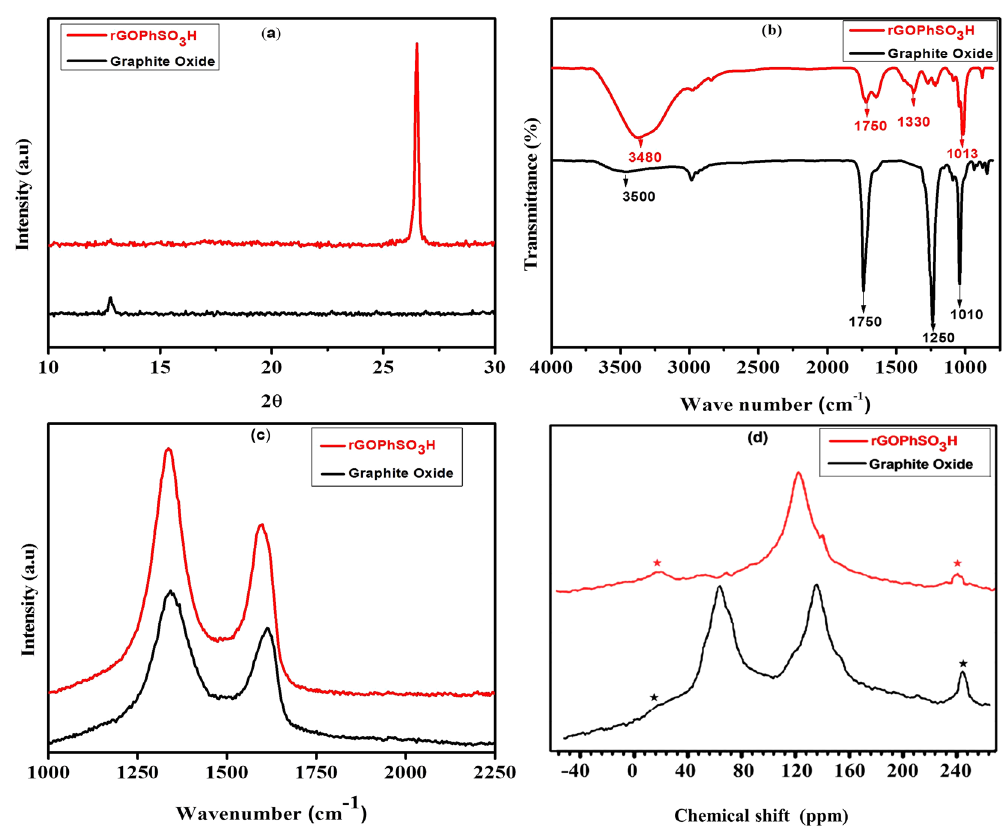
Figure 4. X-ray diffraction ( b ) FT-IR spectra, ( c ) Raman and ( d ) Solid state 13 CMAS spectras of graphite oxide and sulfonated graphene oxide